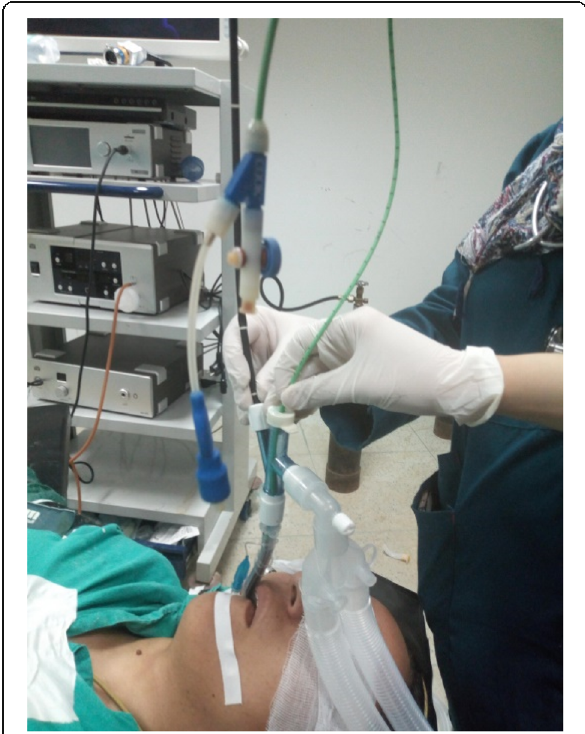
Fig. 3 Insertion of the Cohen® Flex-Tip blocker after the insertion of fiber optic cable through the single lumen